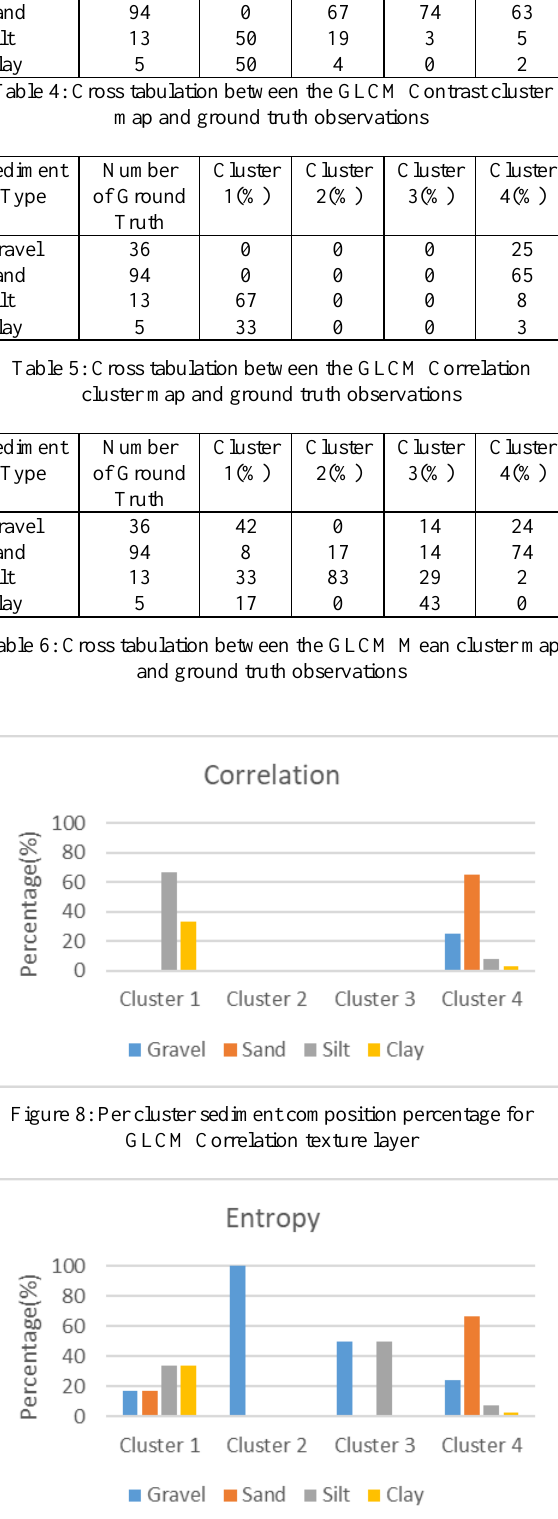
Figure 9: Per cluster sediment composition percentage for GLCM Entropy texture layer